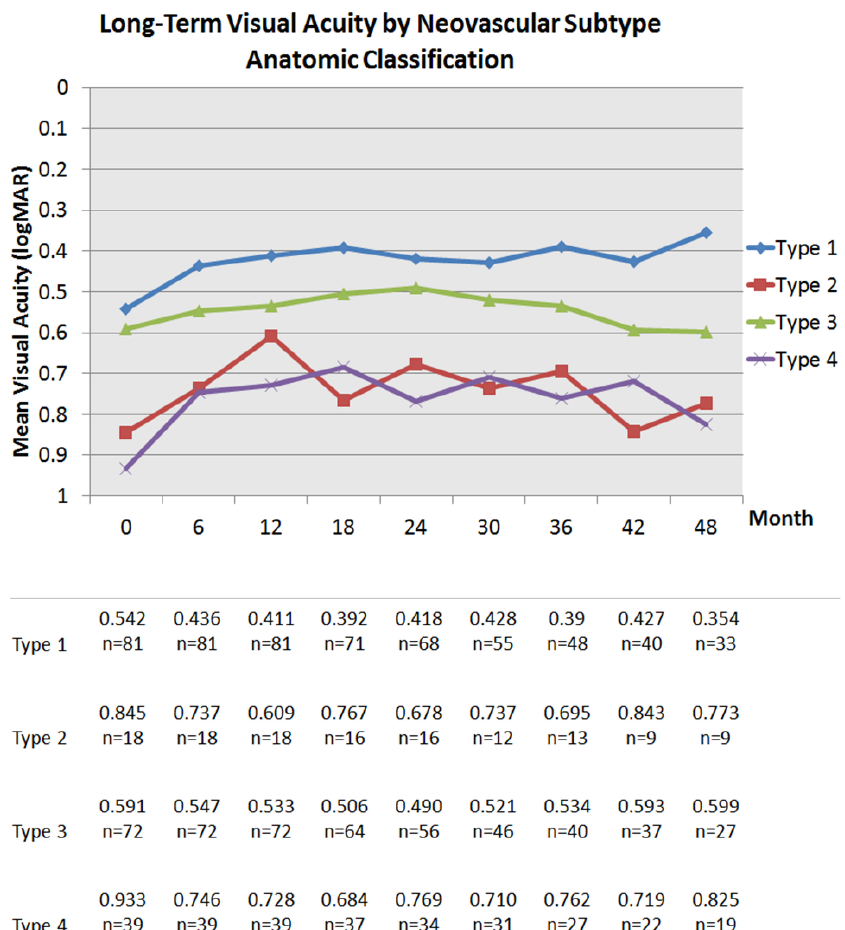
Figure 3. Mean visual acuity in logMAR by neovascular subtype using the anatomic classification. The number of eyes for each neovascular subtype is reported at each time point.